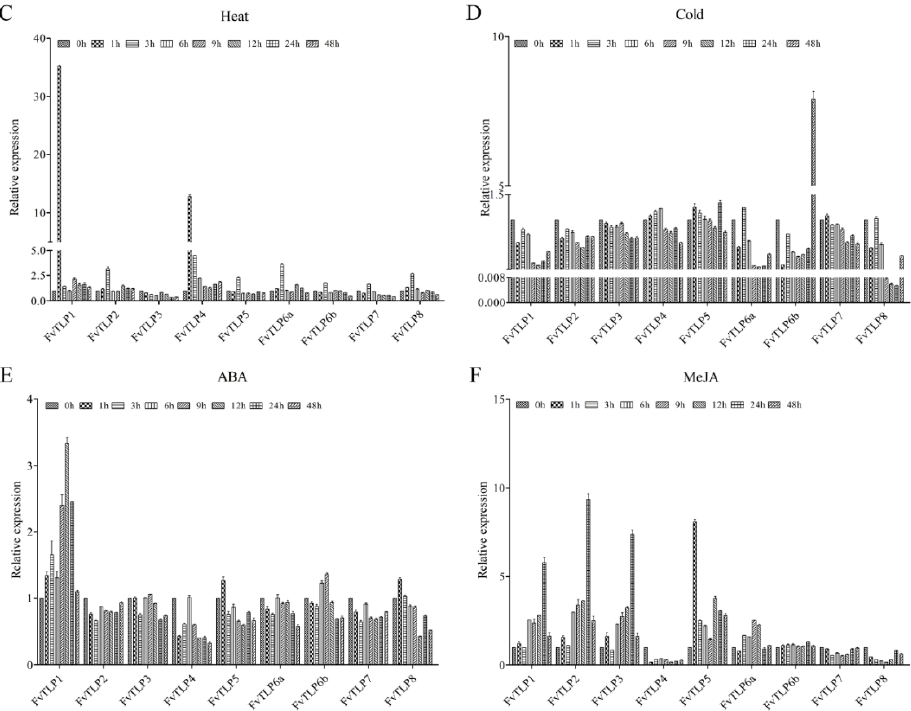
Figure 8. Responses of FvTLP s to various abiotic stresses and hormone treatments. The expression profile of FvTLP s in the leaves under NaCl (150 mM) treatment ( A ), PEG 6000 (10%) treatment ( B ), heat (42 °C) treatment ( C ), cold (4 °C) treatment ( D ), ABA (100 μM) treatment ( E ), and MeJA (100 μM) treatment ( F ).